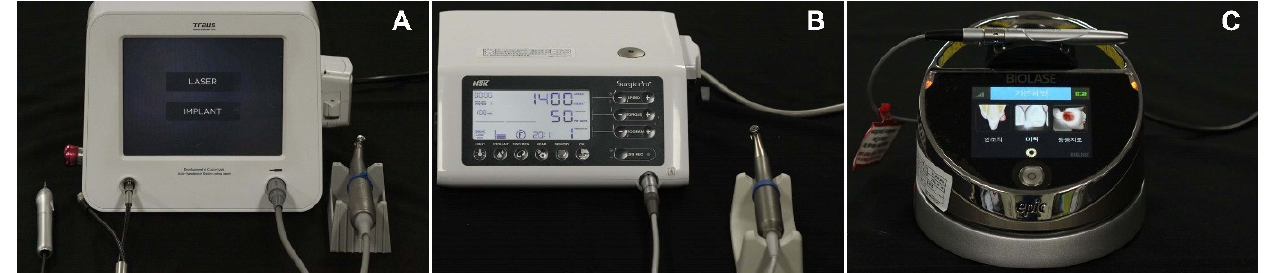
Figure 1. Handpiece system. ( A ) Multi-laser handpiece system (Experimental group). ( B ) Conven- tional implant handpiece system (control group). ( C ) Conventional laser handpiece system (control group).